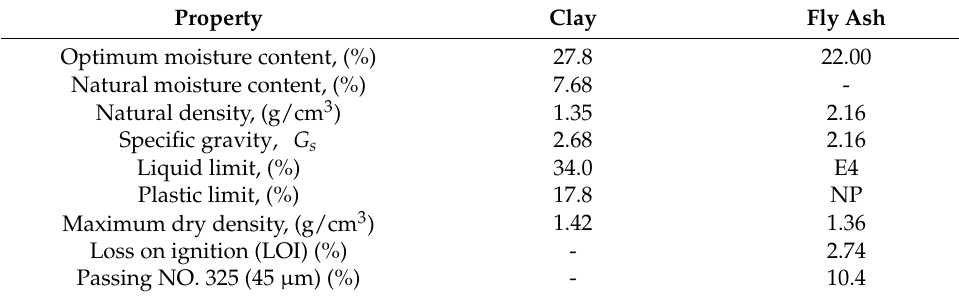
Table 1. Physical properties of clay and fly ash.